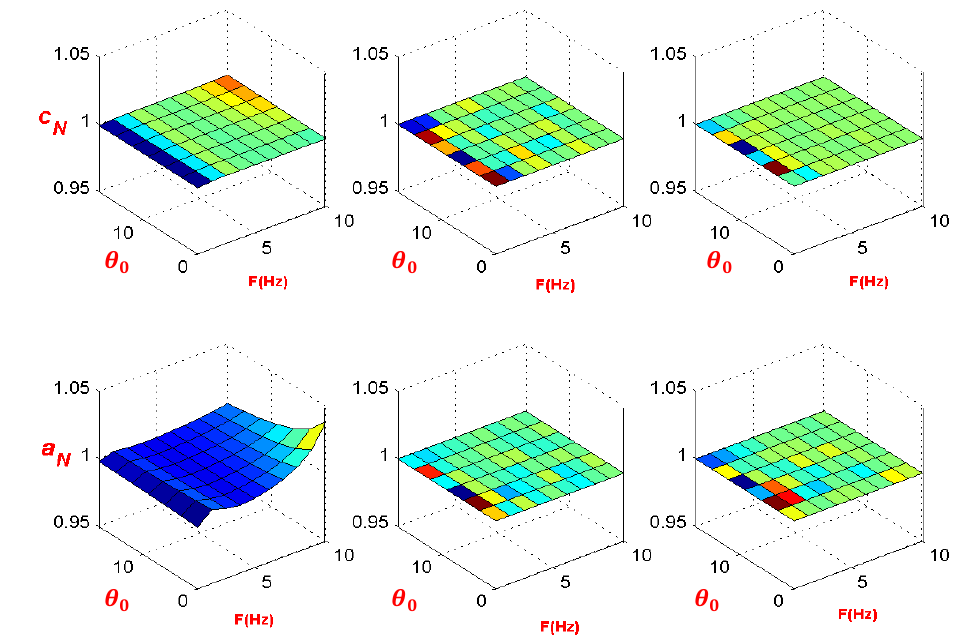
Fig. 4 Three dimensional view (see legend Fig.2) of frequency pattern of normalized phase velocity and normalized attenuation for various wall viscosity ( (cid:2242) (cid:2777) = (cid:2777) (cid:2197) ,(cid:2780) (cid:2197) ,(cid:2783) (cid:2197) , (cid:2786) (cid:2197) , (cid:2778)(cid:2779) (cid:2197) , (cid:2778)(cid:2782) (cid:2197) , (cid:2778)(cid:2785) (cid:2197) (cid:4667) . Both, phase velocity and attenuation obtained are in good agreement with theoretical values. It accuracy of the three